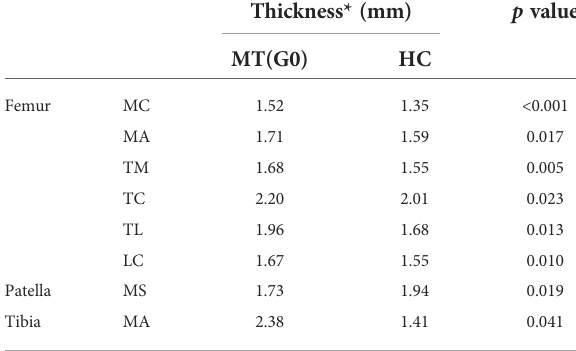
TABLE 7 Comparison of thickness of the articular cartilage 21 subregion between the healthy control group and the meniscus tear group Grade 0 subgroup (only showing the subregions with signi fi cant